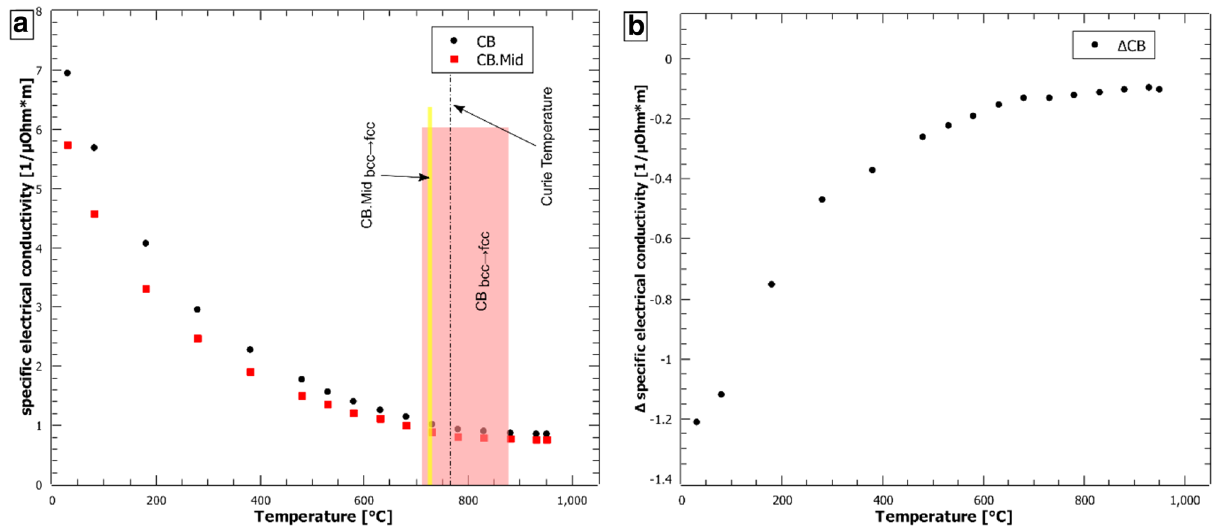
Fig. 4 Electrical conductivity measured over a temperature range from room temperature to 950 °C. Shown are both, collector bar in its initial condition and after "end of service life"-condition ( a ).